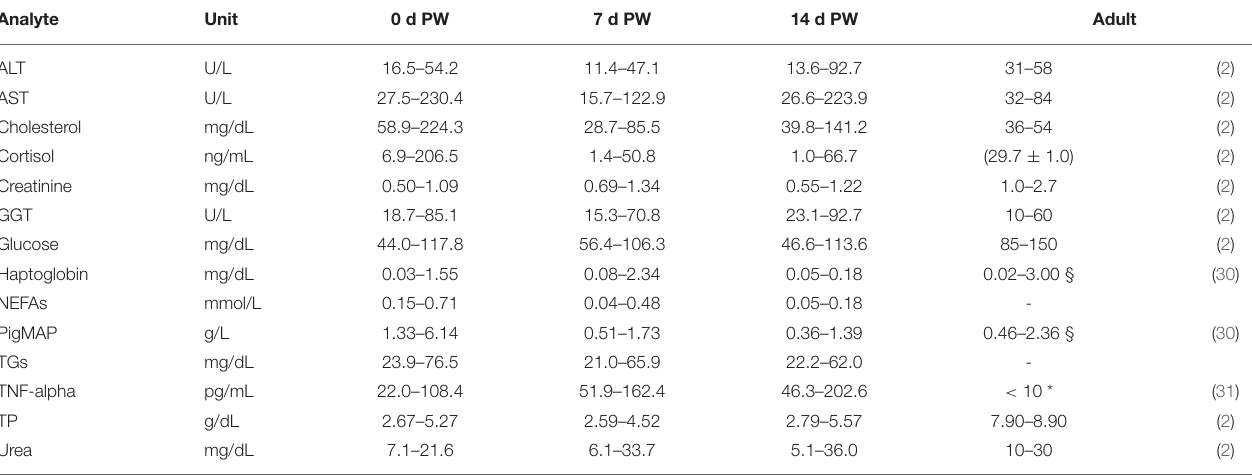
TABLE 4 | Reference intervals (RIs) of clinical biochemistry analytes from piglets at 0, 7, and 14 days post-weaning (PW) (at 21, 28, and 35 days of age) and RIs of adult pig from literature.